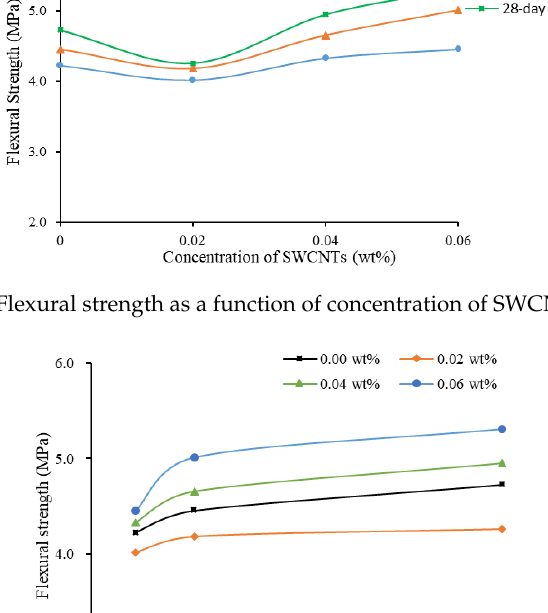
Figure 10. Flexural strength as a function of concentration of SWCNTs (TX10).